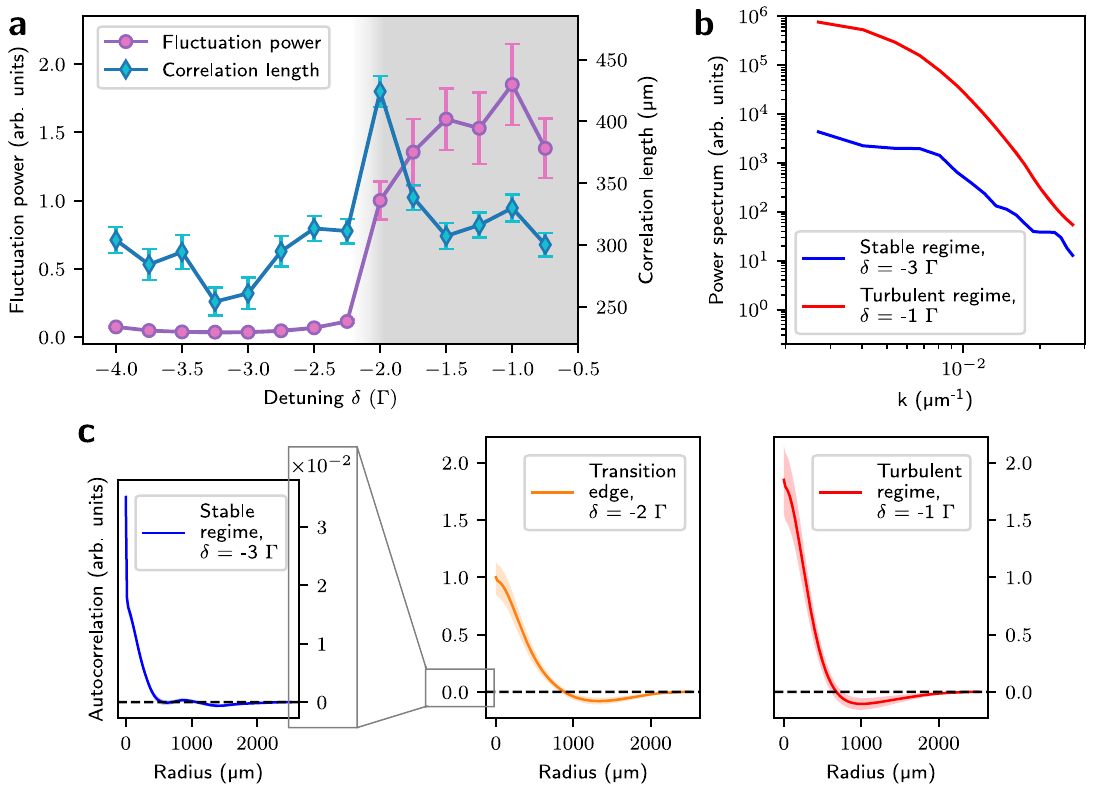
Fig. 2 Transition into the regime of photon bubble turbulence. a Correlation length and total power of relative atom density fl uctuations as a function of laser detuning δ , showing the transition into a turbulent regime where fl uctuations are of the same order as the average density. Error bars correspond to 2 σ variations over different realizations of the experiment. b Stable-turbulent transition in the power spectrum domain. c Typical radial auto-correlation function of density fl uctuations in the stable, transition and turbulent